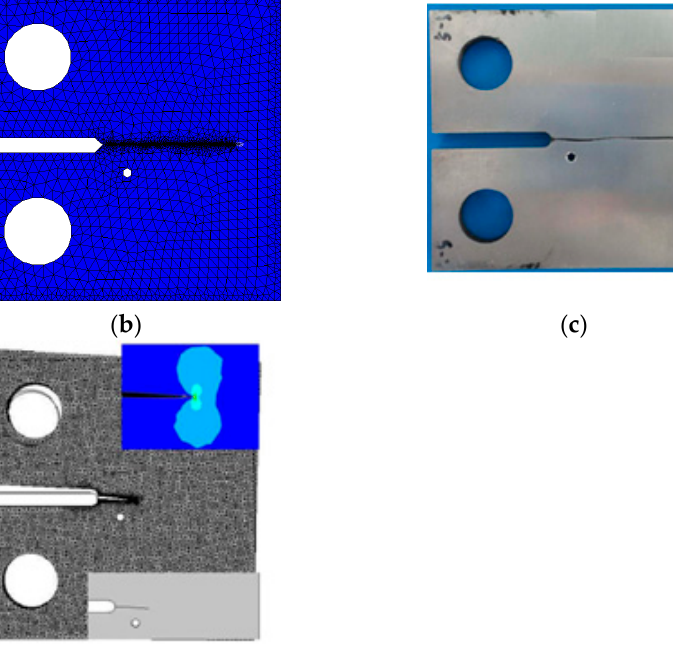
Figure 12. Predicted crack growth path for G5 specimen ( a ) ANSYS Workbench, ( b ) FRANC2D/L and ( c ) Experimental [32], ( d ) numerical [33], ( e ) FRANC3D [32].